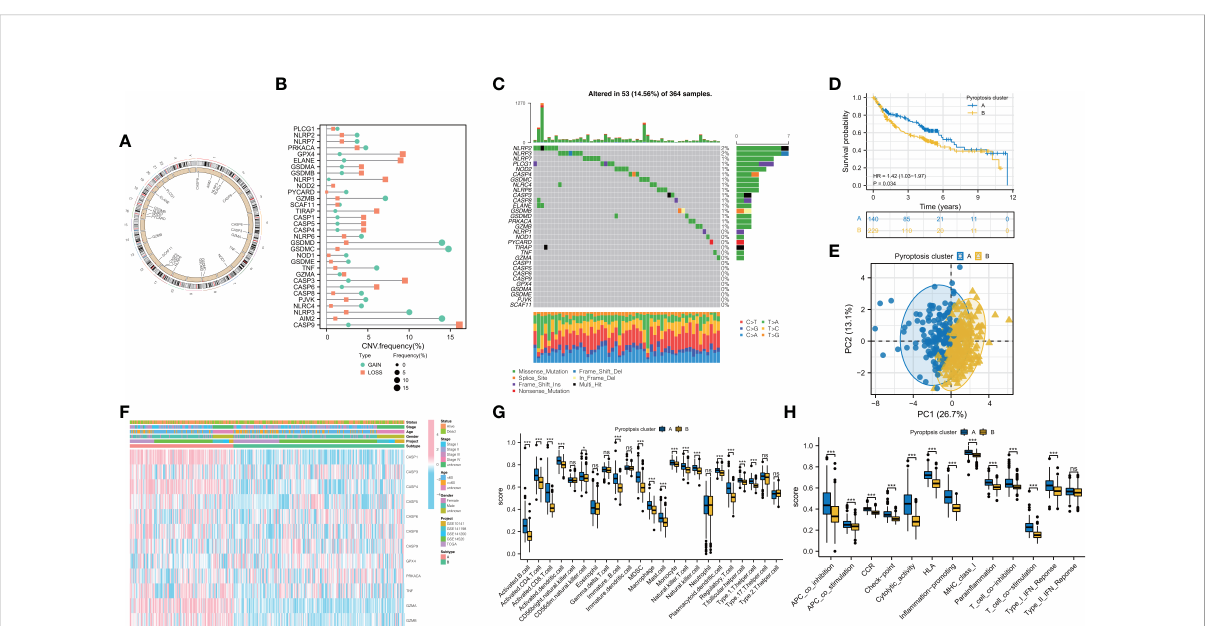
FIGURE 2 Feature and differences of pyroptosis-related molecular patterns in HBV-HCC. (A) The location of CNV of 23 PRGs on chromosomes. (B) The CNV variation frequency of PRGs and (C) the mutation landscape in patients from TCGA-LIHC. (D) Survival curves of the two subtypes. (E) PCA plot based on the expression of PRGs from the 369 HBV-HCC patients veri fi ed the two pyroptosis clusters, A (blue) and B (orange). (F) Heatmap displayed the correlation between the subtypes and clinical features. (G, H) The immune in fi ltrations (G) and functions (H) scores between the two subtypes. PRGs, pyroptosis-related genes; CNV, copy number variation. ; *P < 0.05; ***P < 0.001; ns, not statistically signi fi